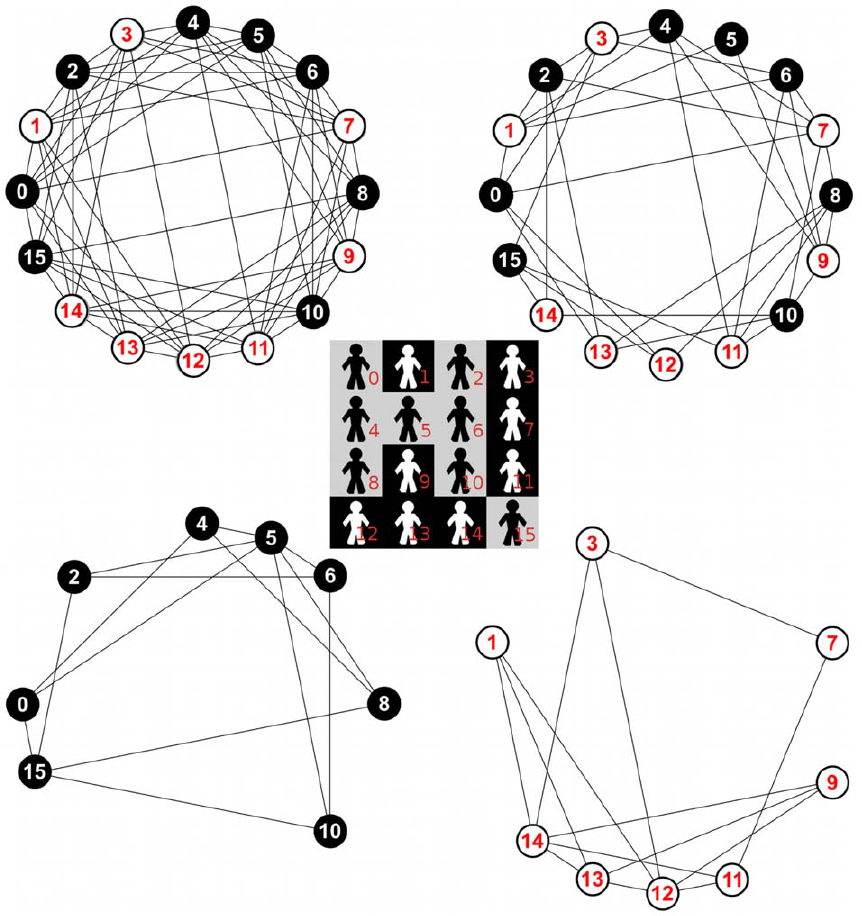
Figure 1. Example of a spatial distribution and its corresponding interaction networks. The spatial distribution, depicted in the centre, consists of 16 agents randomly distributed in a regular 2-dimensional toroidal lattice of 4 6 4 cells. The corresponding set of interaction networks are shown in the corners: (i) the complete interaction network (upper left corner), (ii) the intertype interaction network (upper right corner), (iii) the ‘‘black tag’’ intratype interaction network (bottom left corner), and (iv) the ‘‘white tag’’ intratype interaction network (bottom right corner).